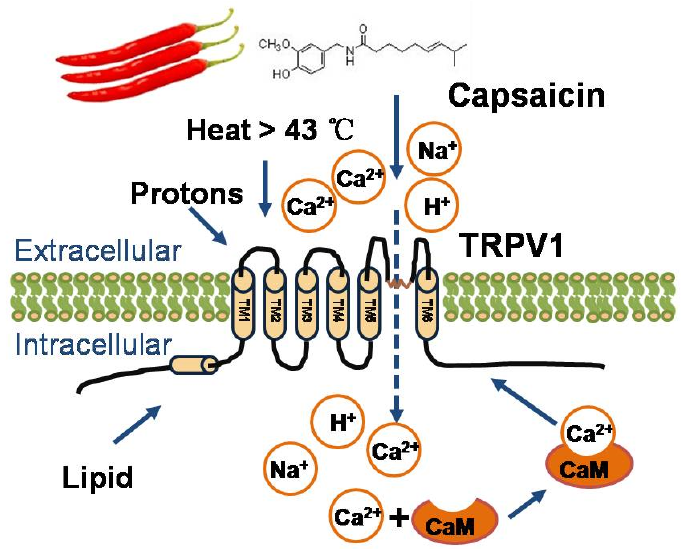
Figure 1. Structural and physiological function of TRPV1. TRPV1 is composed of six